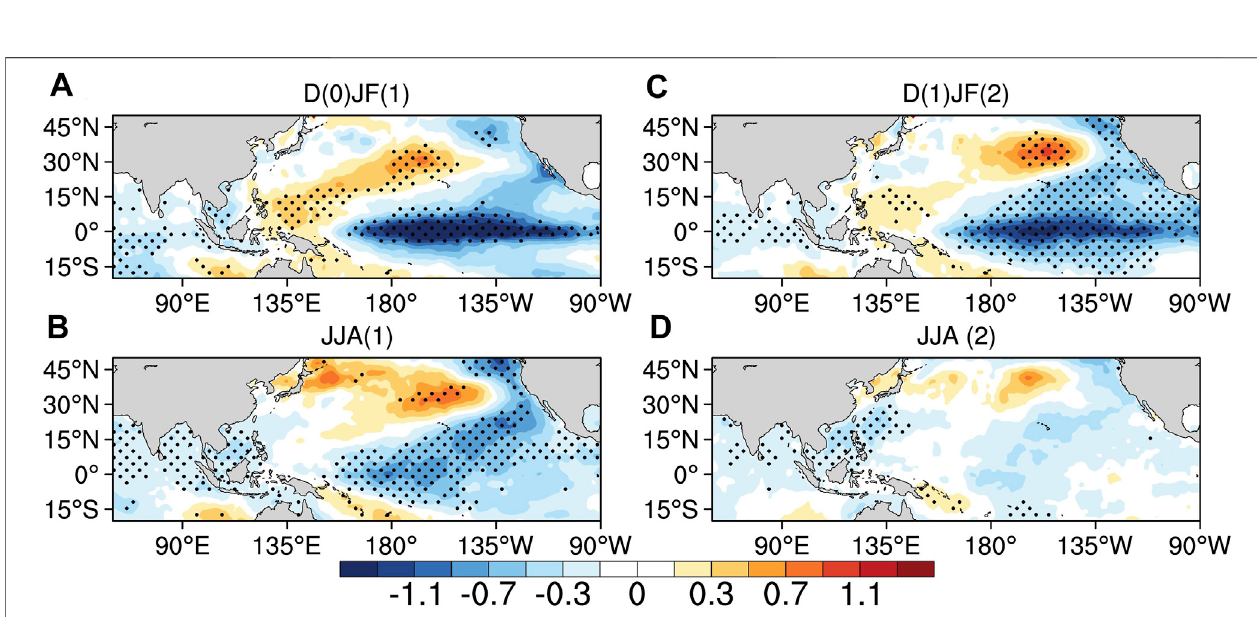
FIGURE2| CompositesofSSTanomalies(units: ° C)forMYLNin (A) D(0)JF(1), (B) JJA(1), (C) D(1)JF(2),and (D) JJA(2).Dottedareasindicatevaluesexceeding the 90% con fi dence level determined using a two-tailed Student ’ s t test.